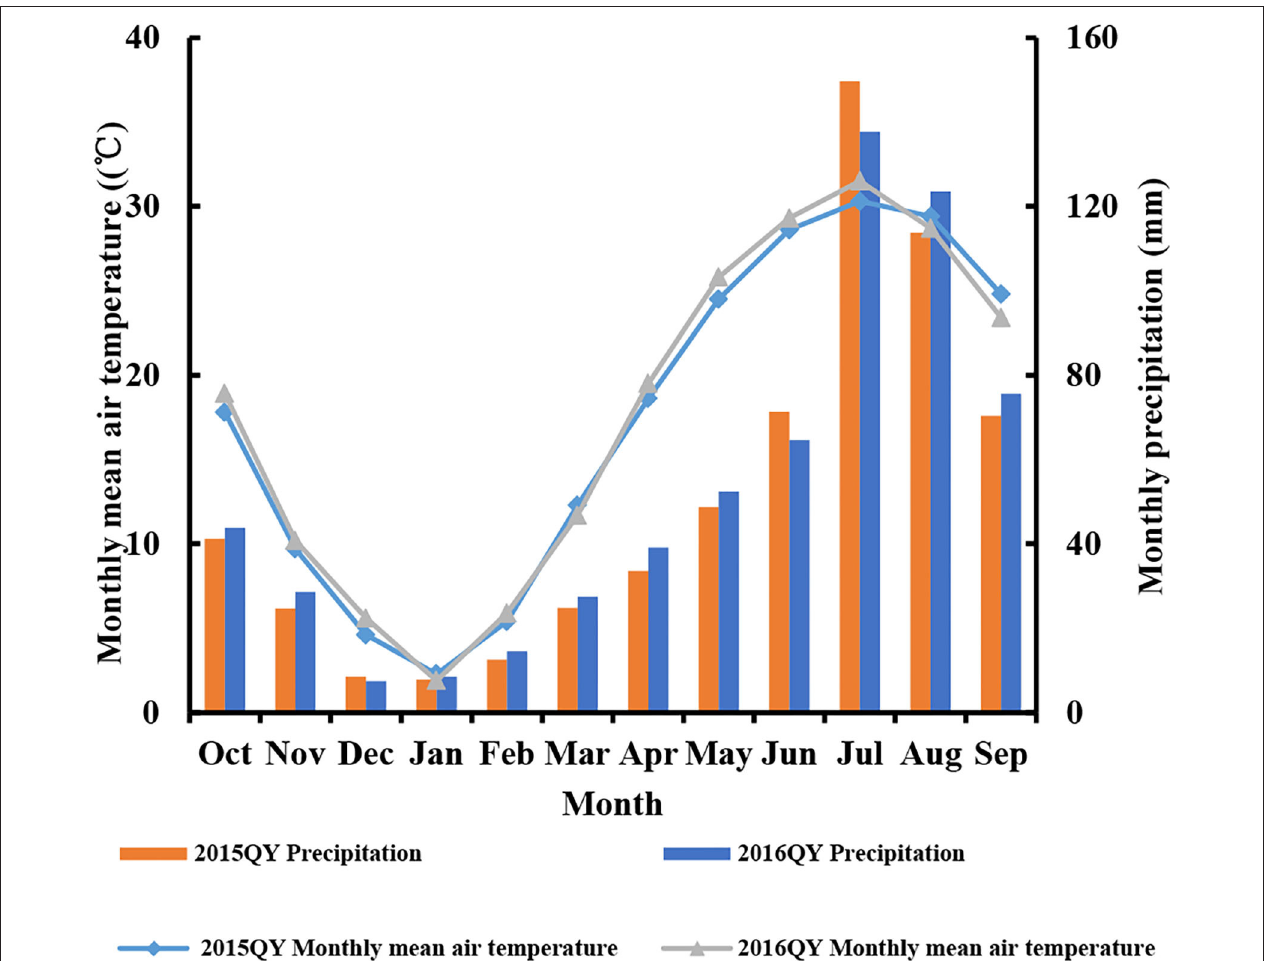
FIGURE 1 | Monthly mean air temperature ( ◦ C) and precipitation (mm) during the 2015 and 2016 seasons at Qinyang (QY).